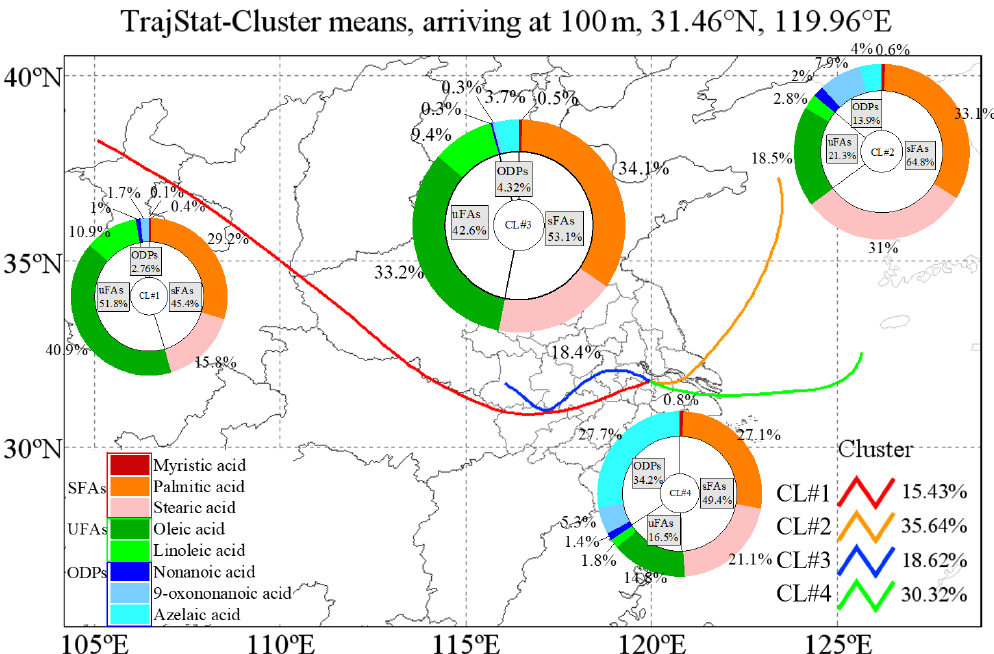
Figure 6. Sources for each air mass during the sampling period. The colored lines in the map show the contribution of each directional air mass source to the total trajectory as resolved by the TrajStat model.